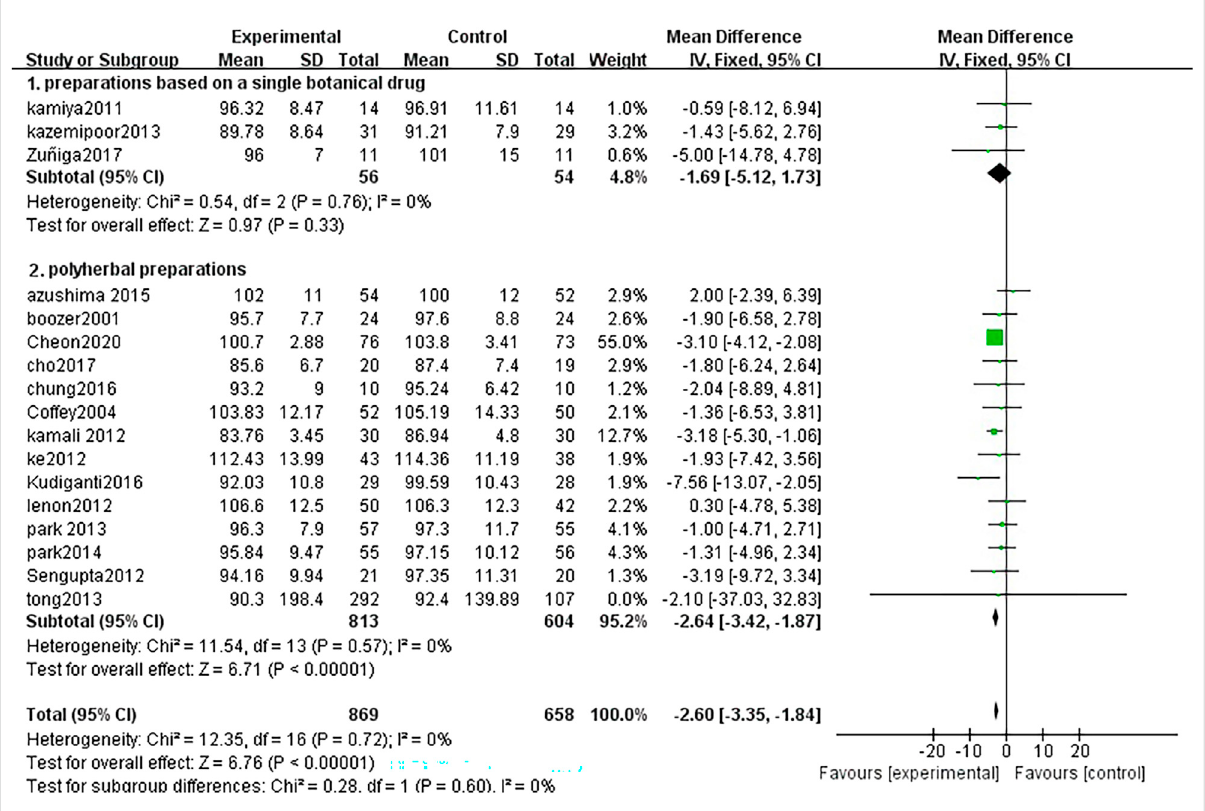
FIGURE 5 Forestplotofwaistcircumference. Comparison:TCMtreatment(1.preparations basedonasinglebotanicaldrug2.polyherbal perparations).vs. placeo or blank control.